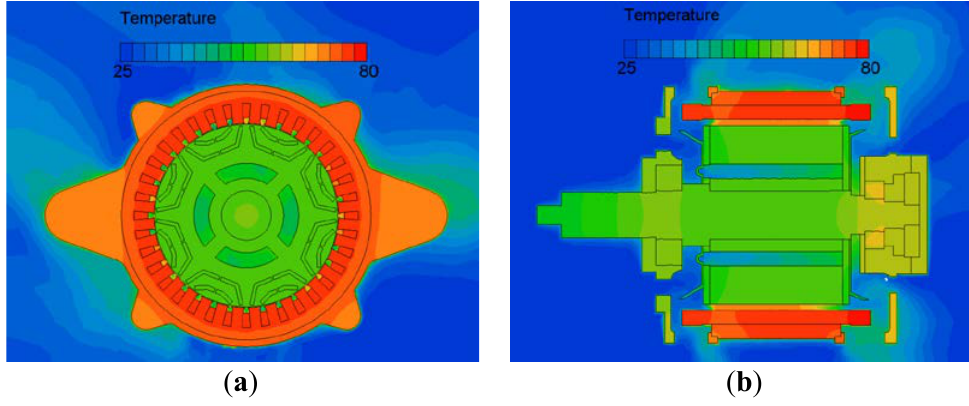
Figure 8. Temperature contours (°C) of ISG motor with an ambient temperature of 25